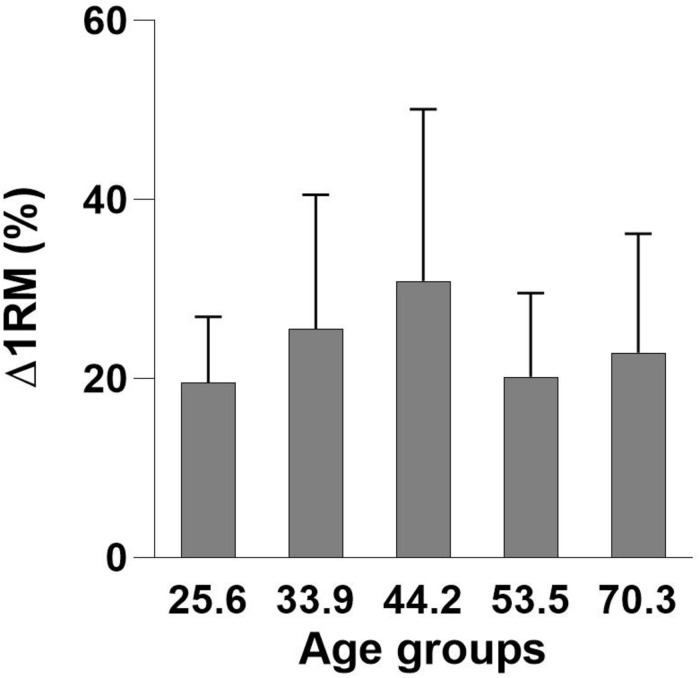
Mean age group improvements (%) in one-repetition maximum (Δ1RM) ± standard deviation (SD).